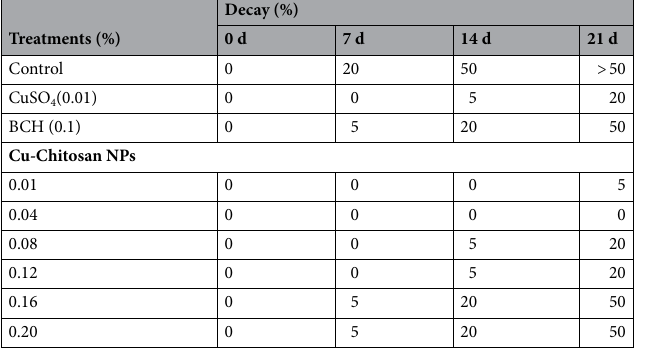
Table 1. Effect of Cu-chitosan NPs on % decay of tomato stored at room temperature. Scale ranging from 1 to 5 were given to each treatment group, where 1 = normal (no decay on fruit surface), 2 = trace (up to 5% of fruit surface decayed), 3 = slight (5–20% of fruit surface decayed), 4 = moderate (20–50% of fruit surface decayed) and 5 = severe (> 50% of fruit surface decayed).Control with water. BCH (bulk-chitosan) dissolved in 0.1% acetic acid and CuSO 4 (0.01%) dissolved in